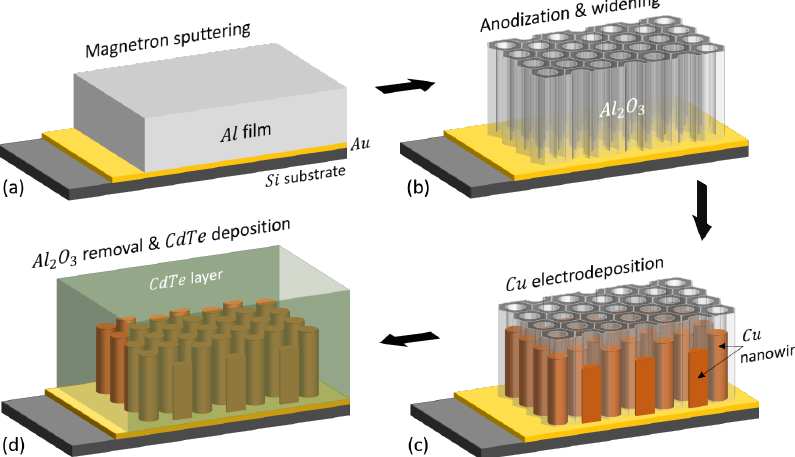
Figure 1. Schematic representation of the fabrication process for obtaining CdTe-embedded in- terfaces based on Cu NWs: ( a ) substrate preparation by in-situ DC magnetron sputtering of Ti (5 nm)/Au (50 nm)/Ti (5 nm)/Al (1 µ m) layers on a <100> p-doped Si substrate (Ti ultra-thin films are not represented for convenience); ( b ) supported nanoporous Al 2 O 3 template fabrication through anodization of the entire Al film and subsequent chemical widening of the nanopores; ( c ) electro- chemical synthesis of Cu within the aluminum oxide (Al 2 O 3 ) nanopores; ( d ) complete removal of the Al 2 O 3 template and CdTe deposition on top of the Cu NW